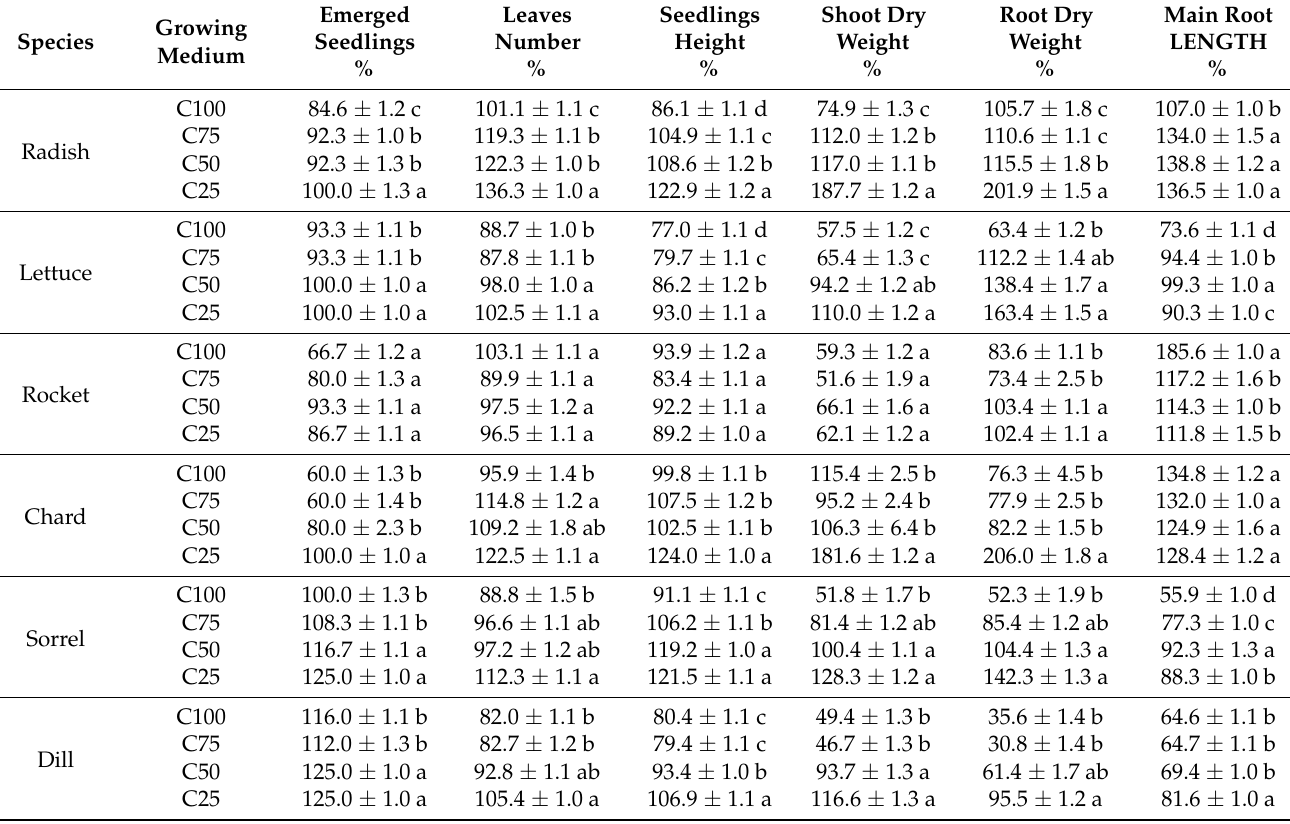
Table 3. Growth parameters measured for each species at the end of survey with respect to the control (%) at the different doses of compost added to the growth